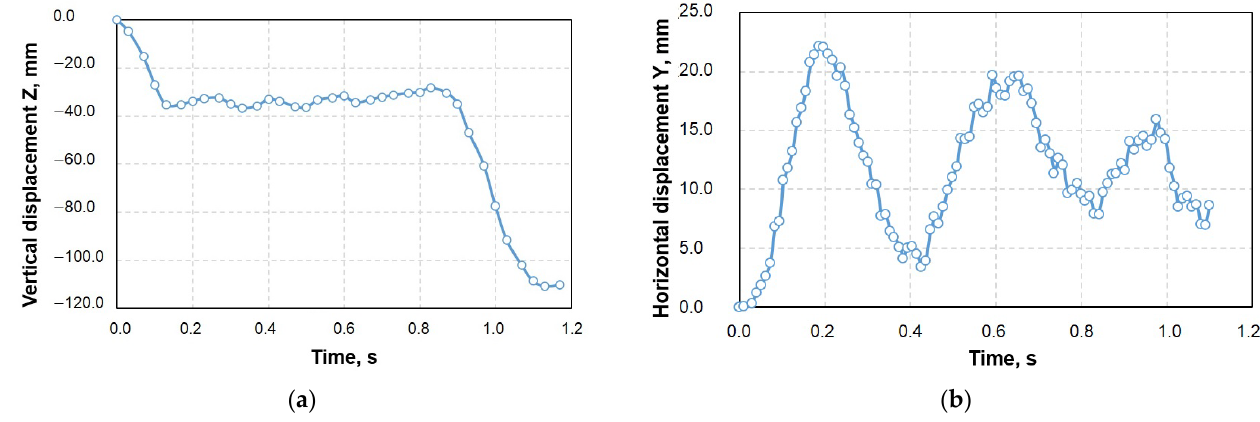
Figure 8. Displacement of the beam-to-column joint after removal of the corner column.